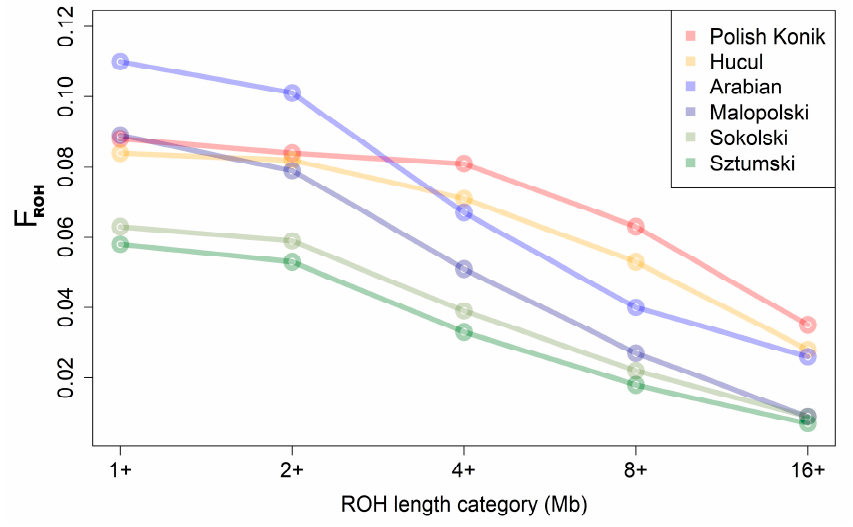
Figure 3. F ROH for the analyzed